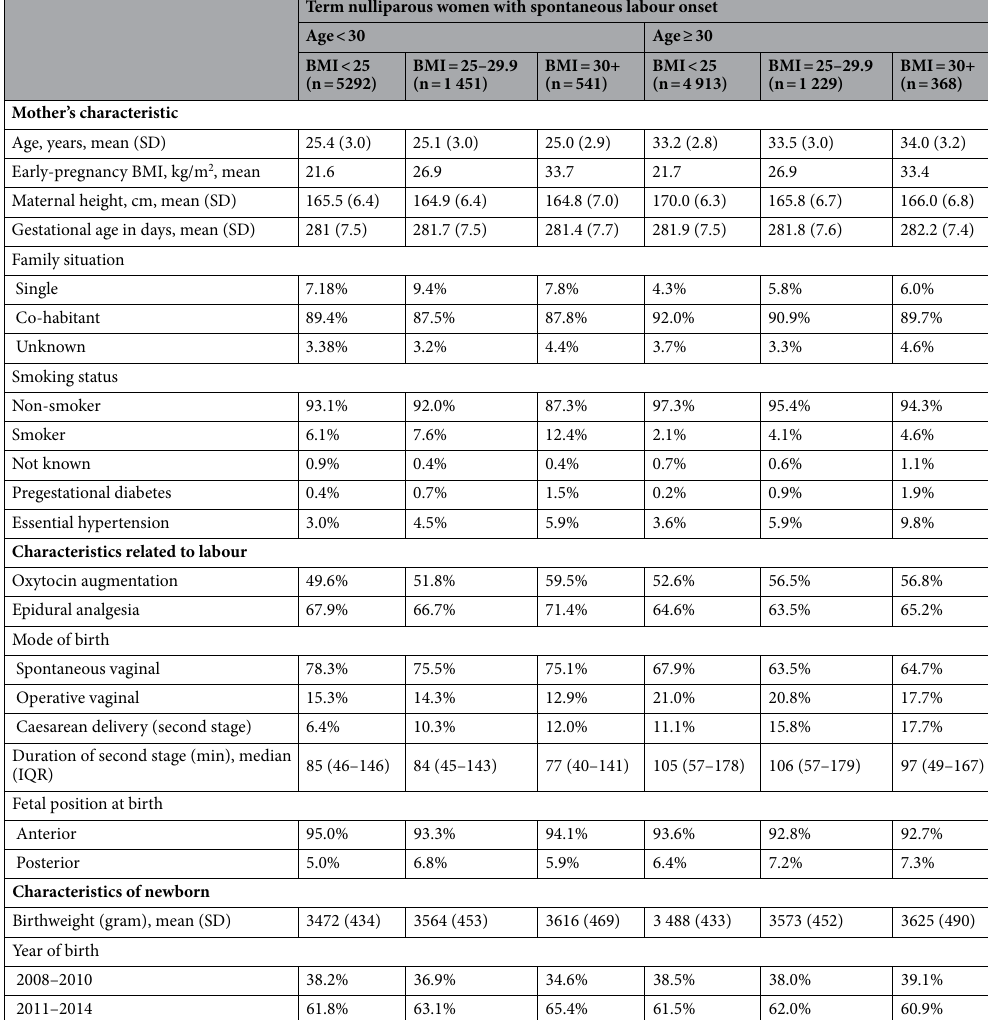
Table 1. Baseline characteristics for the study population 13,794 women.